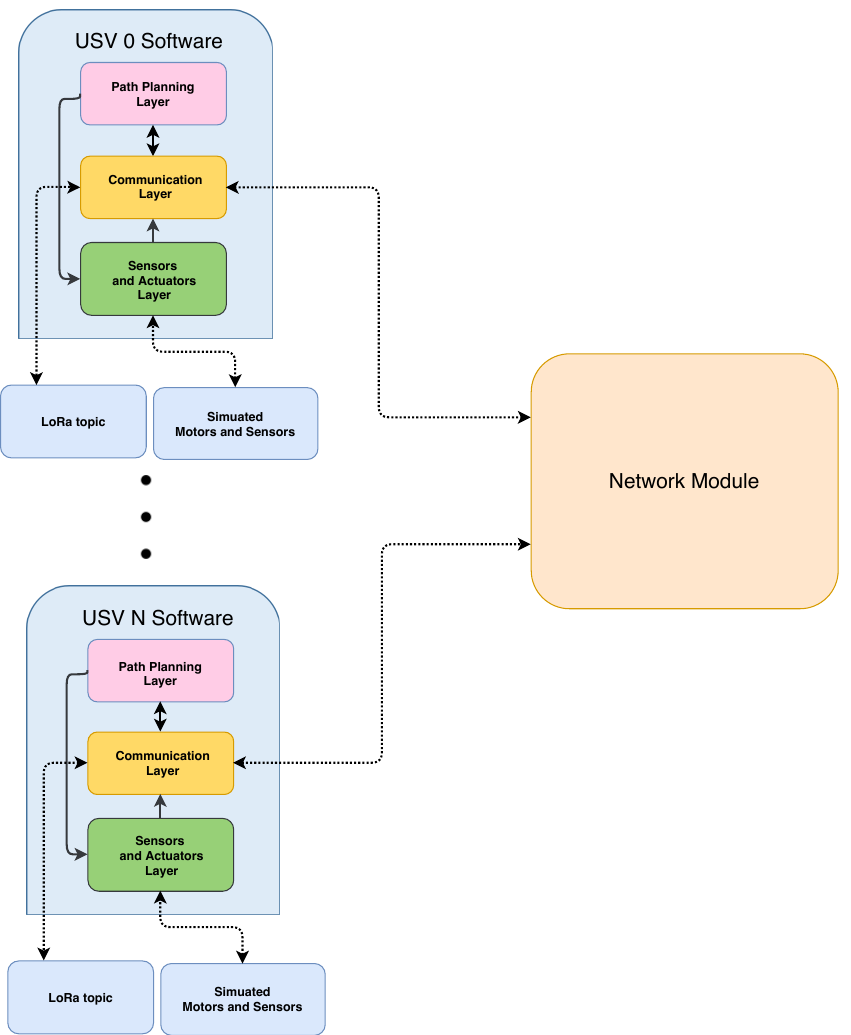
Figure 7. USVs software